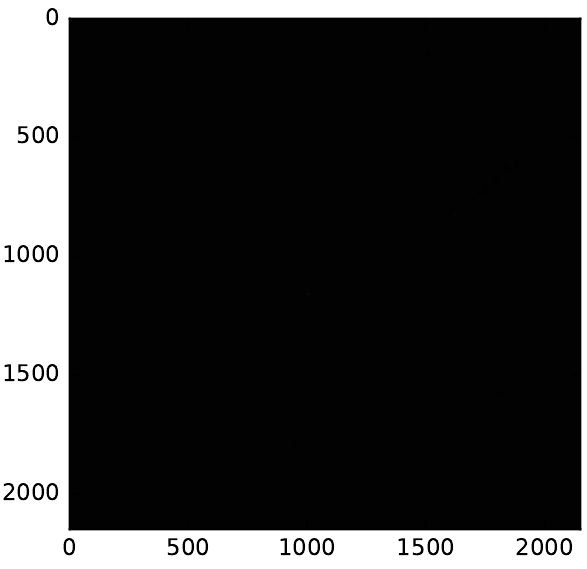
Fig. 98.— HST image of M 16, with adapted